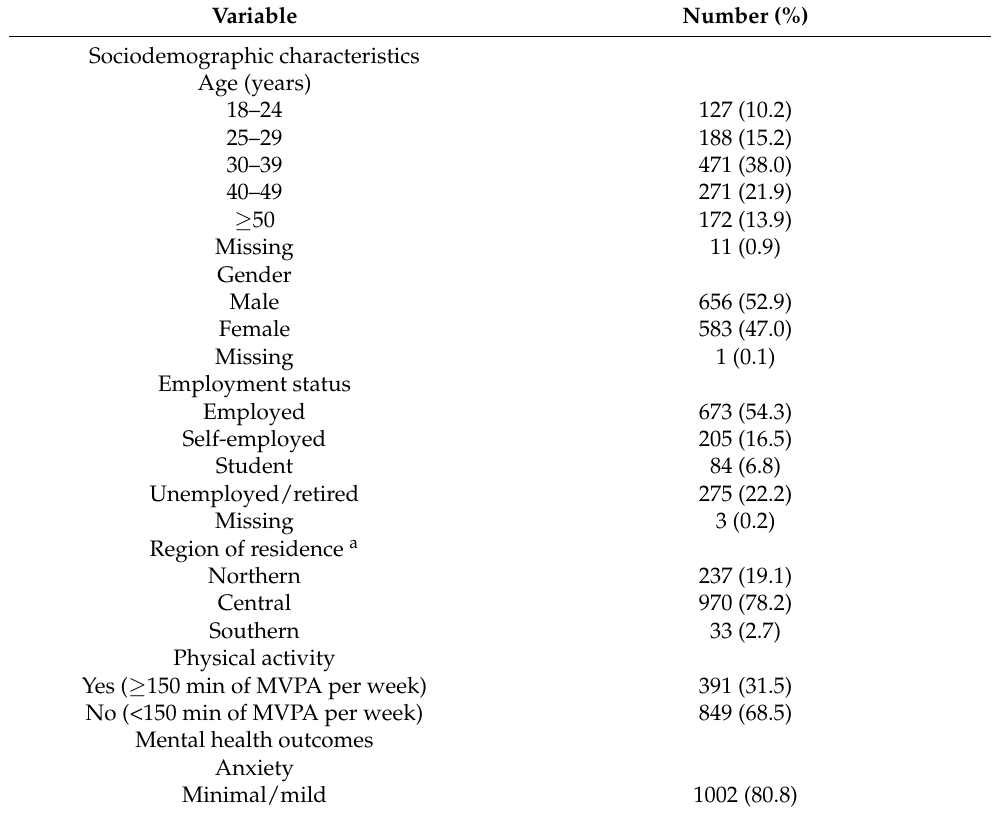
Table 1. Participants’ characteristics (N =